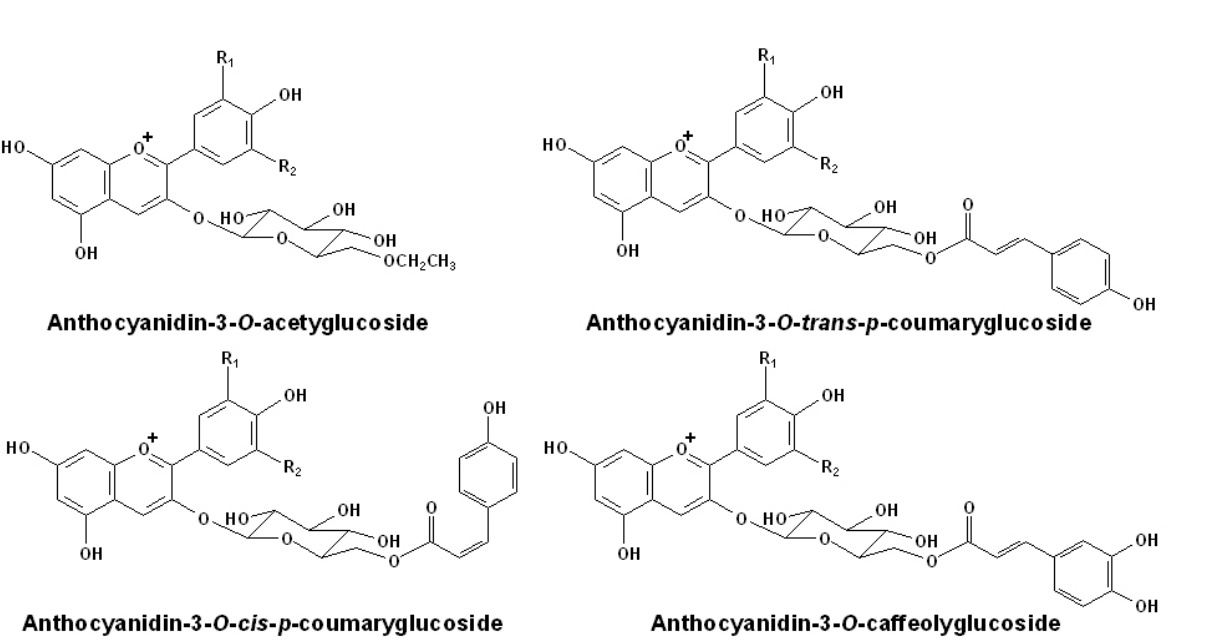
Figure 2. Structures of normal acetylated anthocyanins in grapes